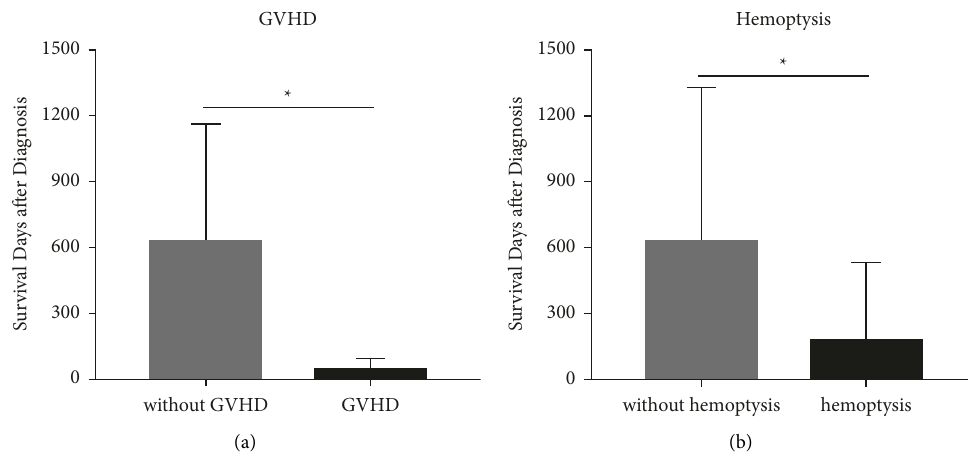
Figure 3: Differences of survival days between patients with or without GVHD and hemoptysis. (a) Among the 21 cases, patients with GVHD had shorter survival days than the patients without GVHD ( p � 0 . 043). (b) Among the 21 cases, patients with hemoptysis had shorter survival days than those who did not have hemoptysis ( p � 0 . 025). ∗ p value is statistically